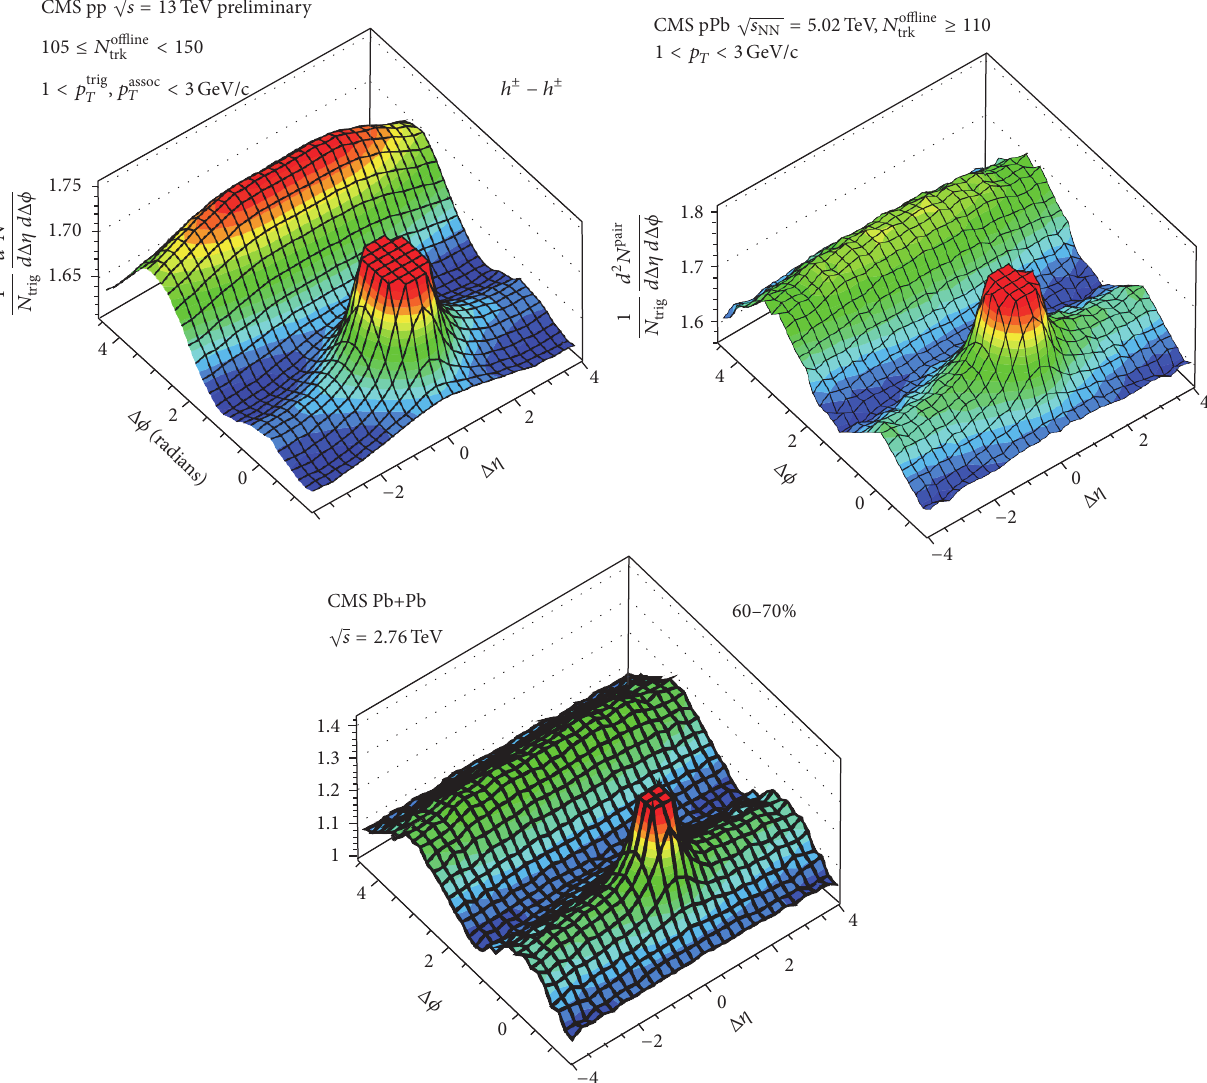
Figure 1: Two-particle correlation function in relative pseudorapidity and azimuthal angle showing long range ridge-like structure in high- multiplicity p+p, p+Pb as compared to peripheral Pb+Pb collisions. Figures are taken from [6, 13,